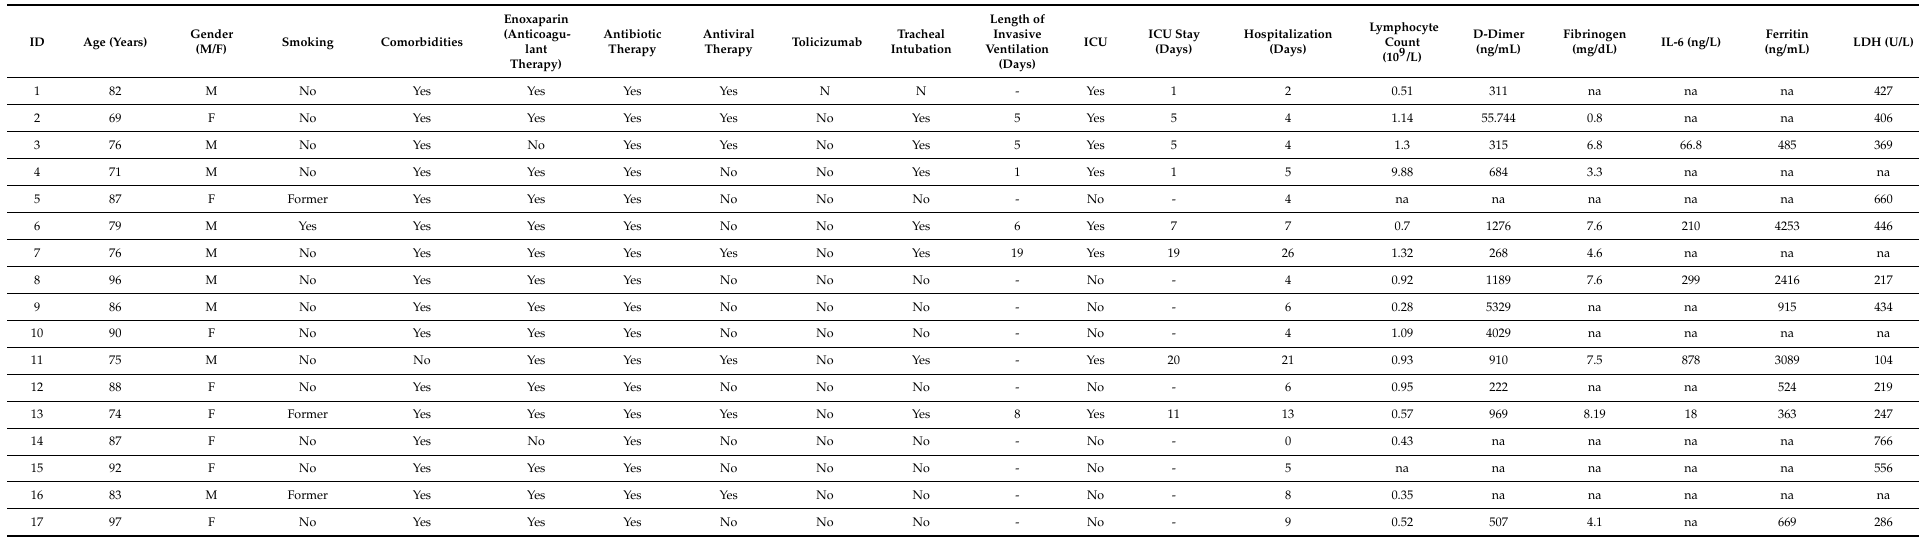
Table 2. Detailed clinical and laboratory data of COVID-19